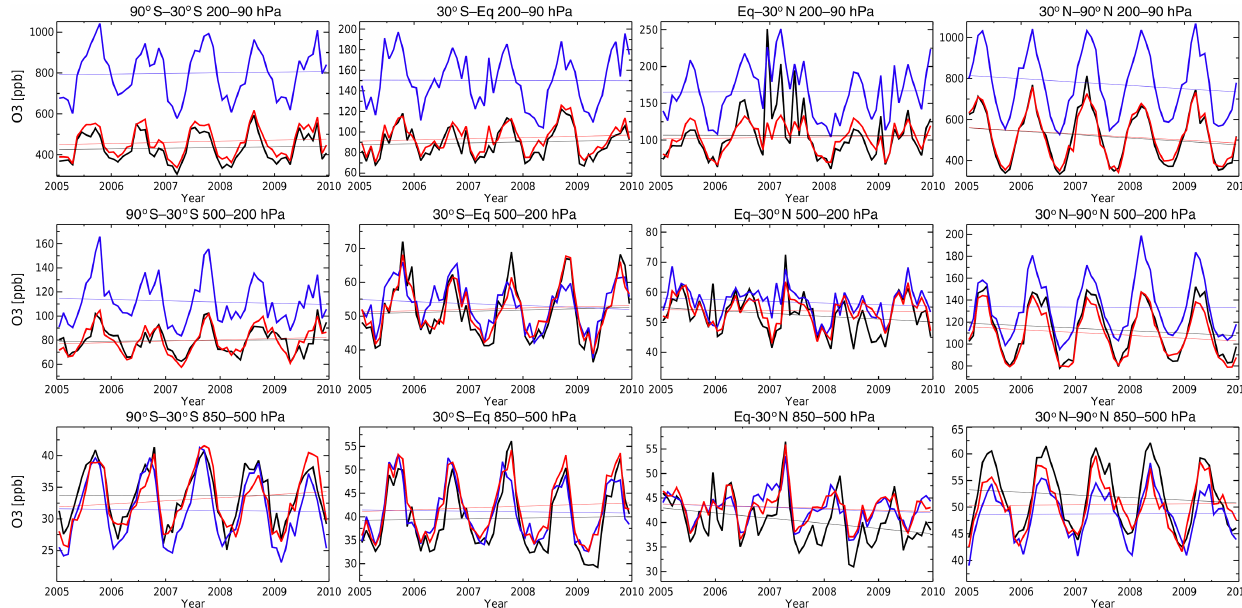
Figure 2. Time series of monthly mean ozone concentrations obtained from ozonesondes (black), control run (blue), and reanalysis (red) averaged between 850 and 500hPa (top), 500 and 200hPa (middle), and 200 and 90hPa (bottom) for 2005–2009. From left to right the results are shown for SH extratropics (30–90 ◦ S), SH tropics (30 ◦ S–Eq), NH tropics (Eq–30 ◦ N), and NH extratropics (30–90 ◦ N).